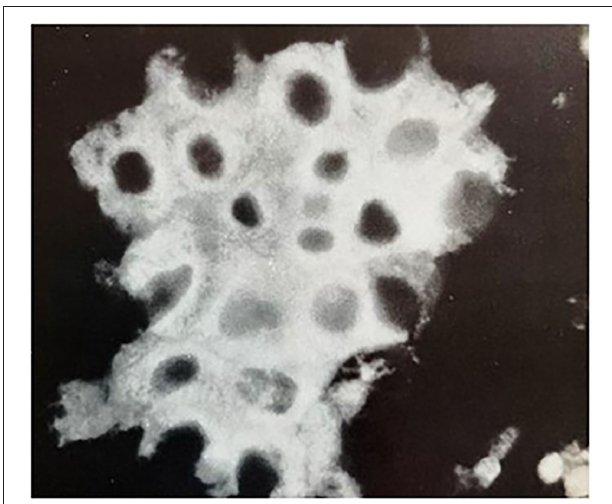
FIGURE 4 | Immunofluorescent localization of AUT-PK 500 in adrenocortical carcinoma 494 cells. Indirect immunofluorescence reaction of rabbit anti-AUT-PK 500 IgG with fixed cells that were freshly isolated from rat adrenocortical carcinoma demonstrated the perinuclear concentration of the enzyme as well as its homogenous cytoplasmic distribution. (Reproduced with permission, Ganguly et al.,